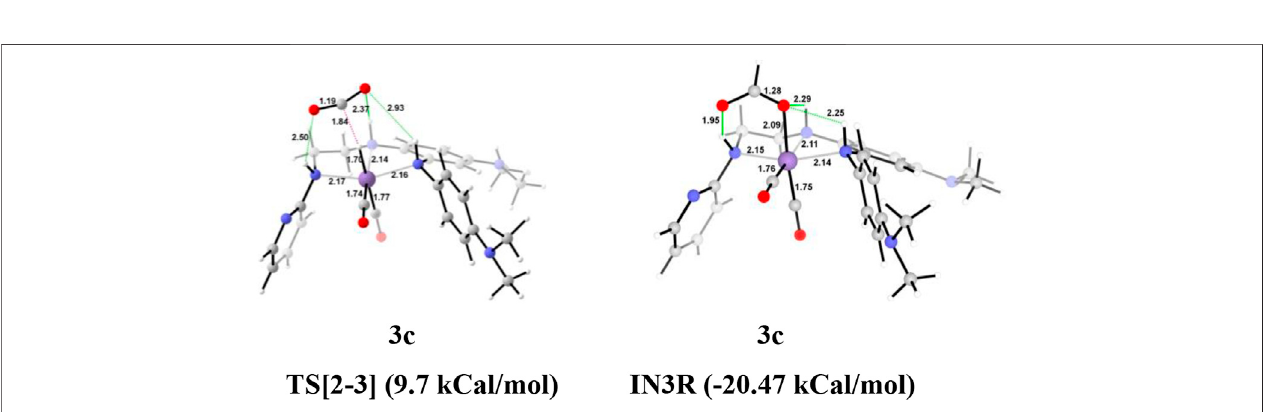
FIGURE 11 | Solvent-corrected relative Gibbs free energy pro fi le for Mn(I)NNN-catalyzed formation of formic acid through the NC pathway for catalysts 3a – 3e . Calculations were carried out at the M06/6-31G(d,p)-SDD(Mn), SMD(H 2 O) level of theory.